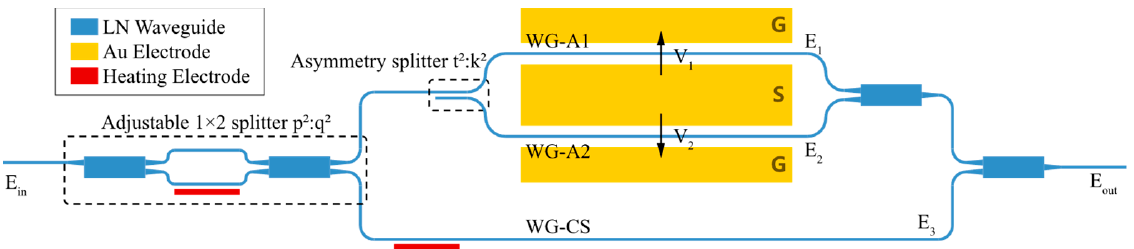
Figure 1. A schematic diagram of the single AMZM.